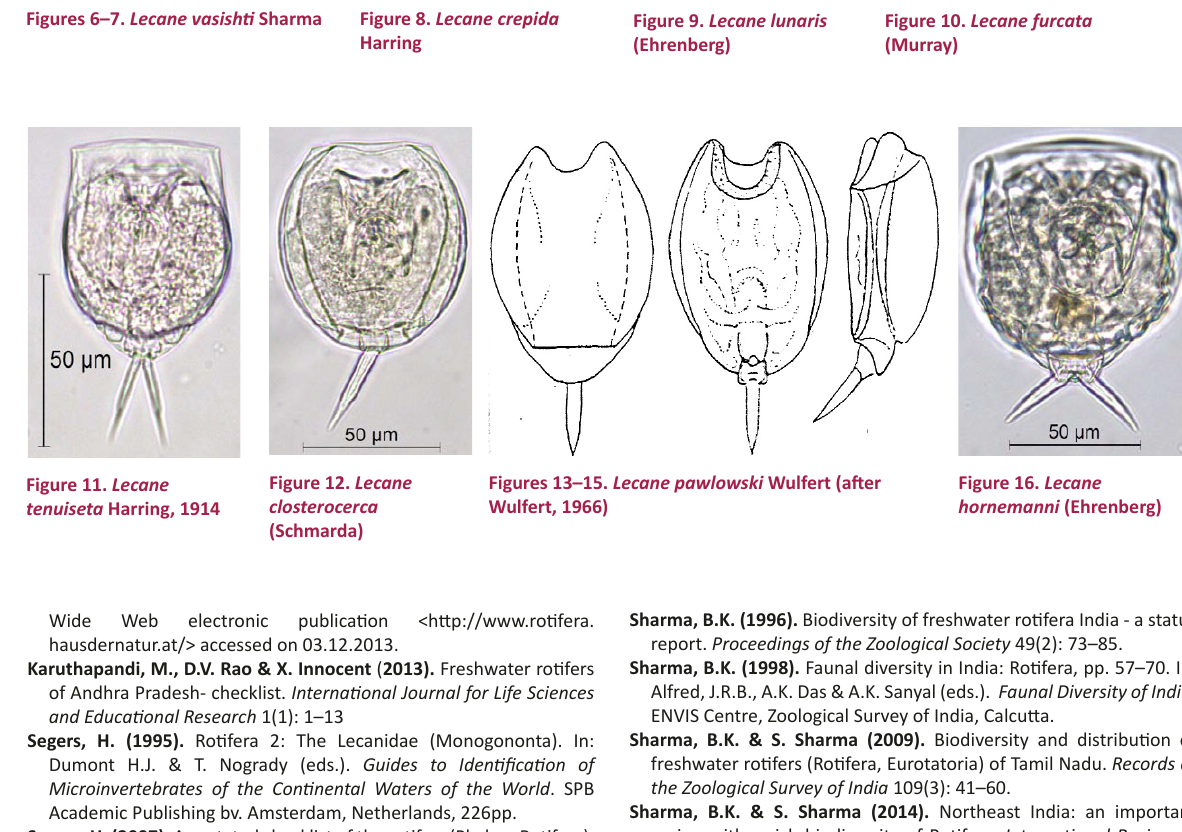
Figures 6–7. Lecane vasishti Sharma Figure 8. Lecane crepida